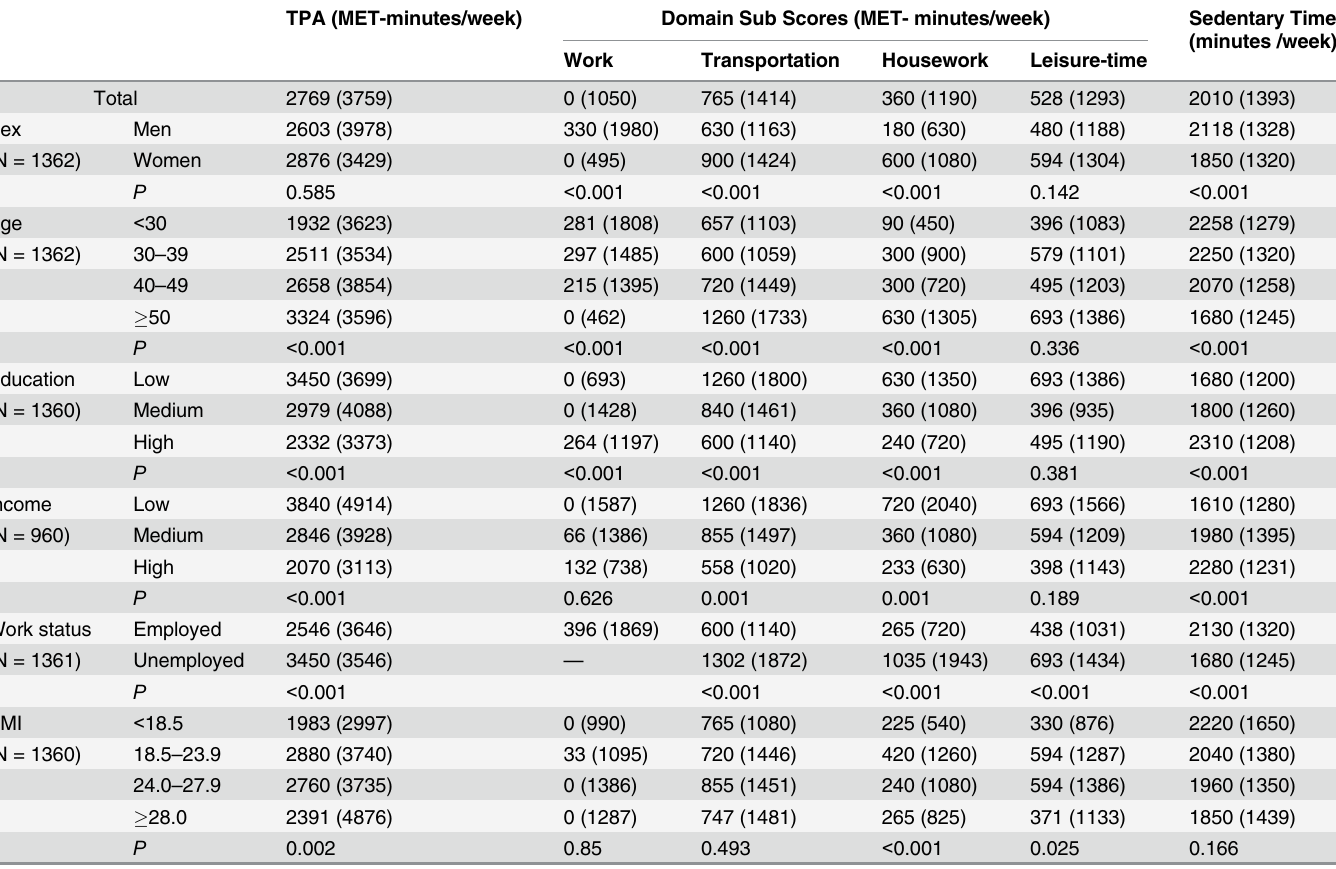
Table 2. Self-reported TPA and physical activity in each domain and sedentary time by socio-demographic variables *